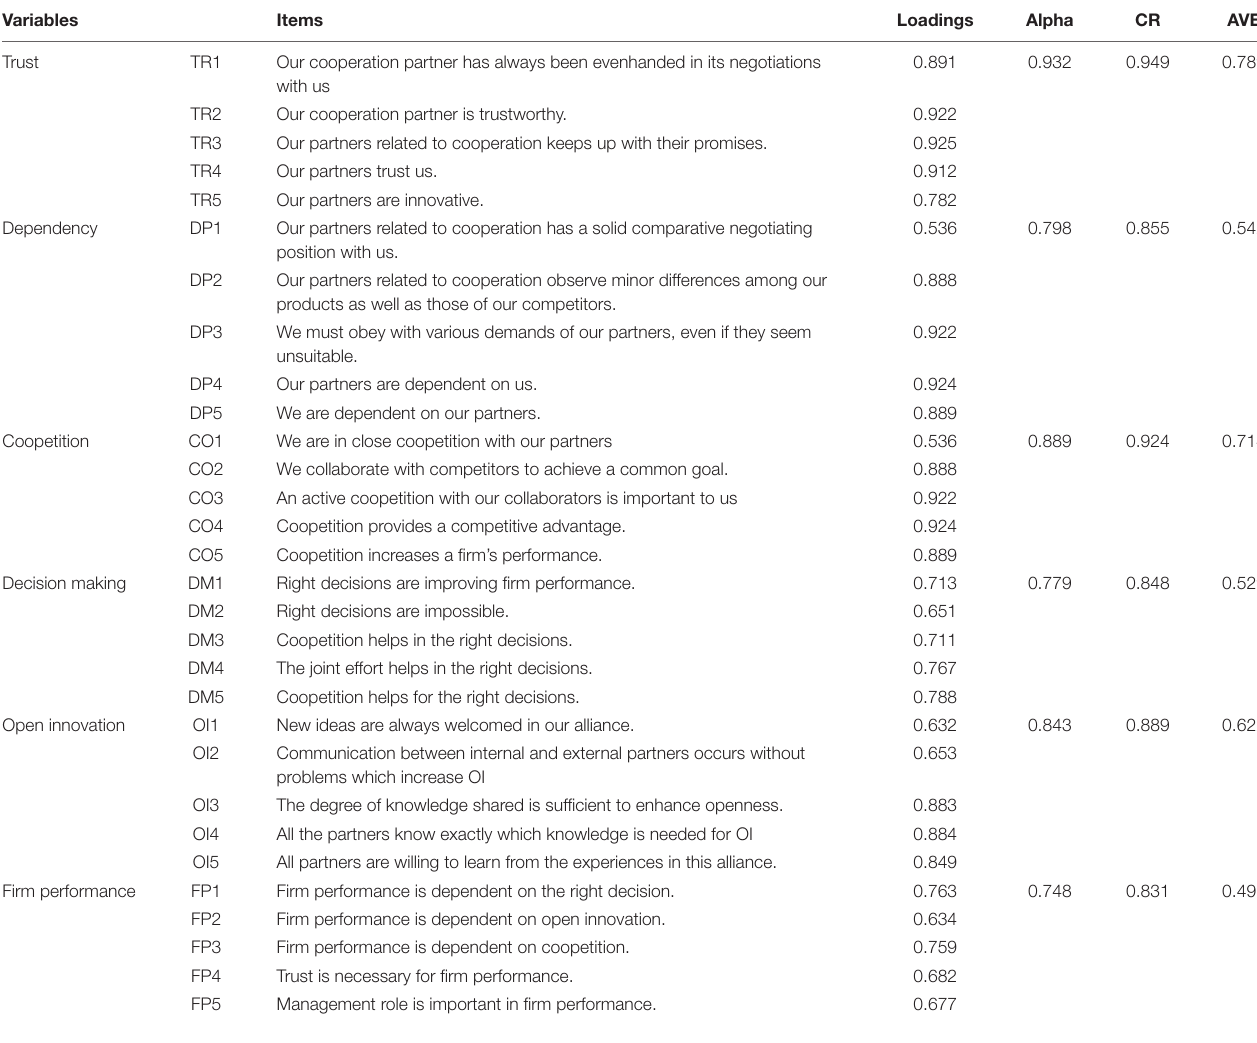
TABLE 1 | Factor loadings, reliabilities, and